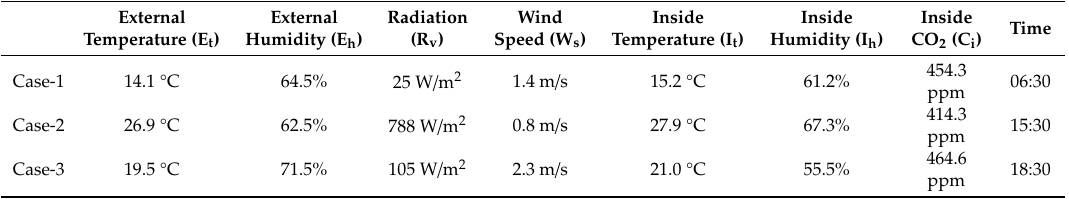
Table 3. Three case environmental conditions to confirm the simulation of the optimization algorithm.